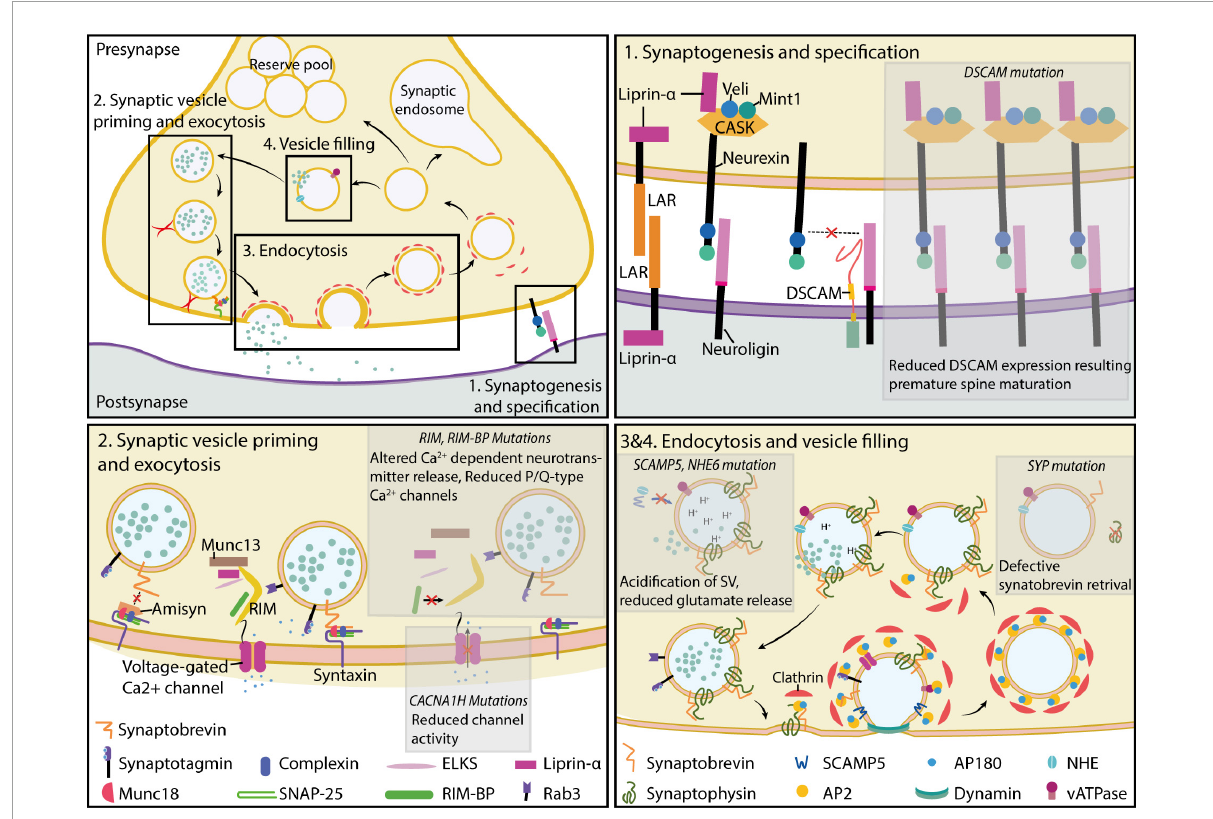
FIGURE1 Molecular players of presynaptic function. Presynaptic formation and function are critically dependent on the expression and localization of proteins involved in the process of synaptogenesis and specification (top right) (section “Synaptogenesis and specification”), synaptic vesicle priming and exocytosis (bottom left) (sections “Synaptic vesicle priming” and “Synaptic vesicle exocytosis”), retrieval of synaptic vesicles (bottom right) (section “Retrieval of vesicle from plasma membrane and endocytosis”), and filling of empty synaptic vesicles (bottom left) (section “Regulation of synaptic vesicle filling and synaptic vesicle pools”). Mutations disrupting presynaptic protein function impair normal synaptic formation and neurotransmission, resulting in a loss of synaptic function. Further discussion of the mutations and their potential implications in autism etiology can be found in the main